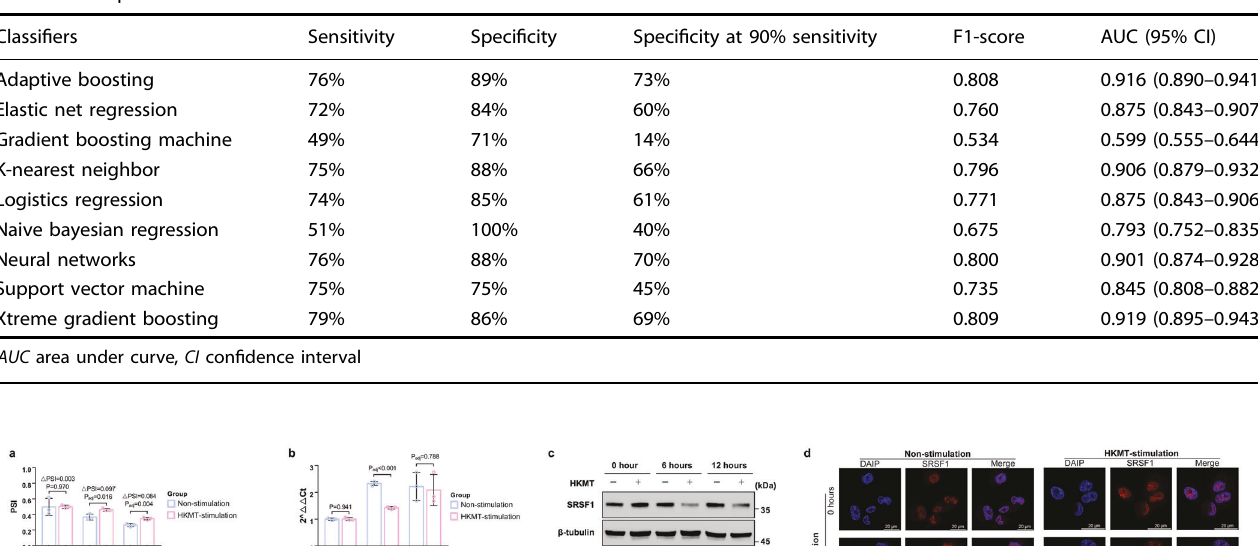
Table 3. The performance of 9 classi fi ers in the test set